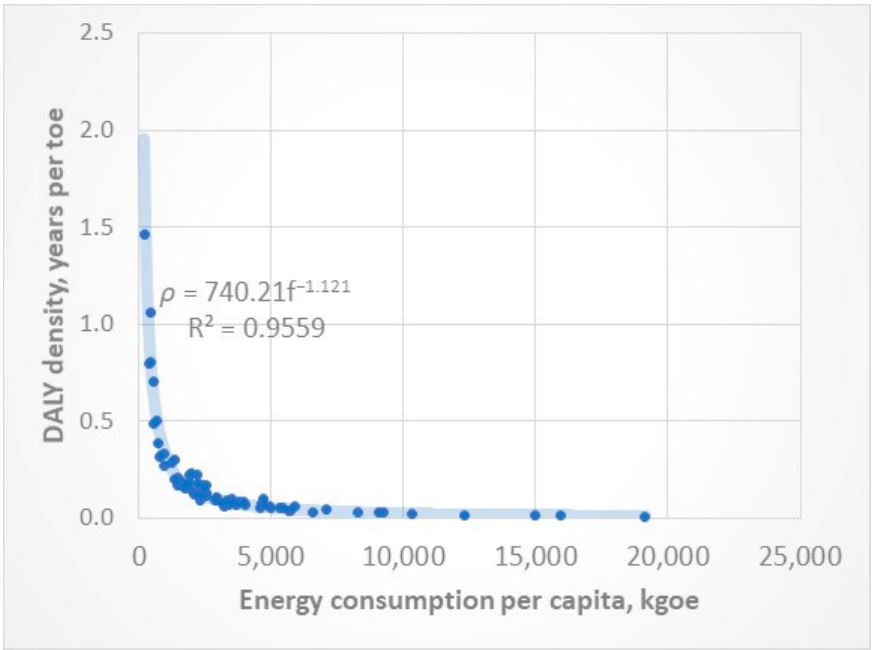
Figure 2. The energy density of disability-adjusted life year (DALY) and energy consumption per capita (2016). Source: Calculated by the authors based on [49,56,58].